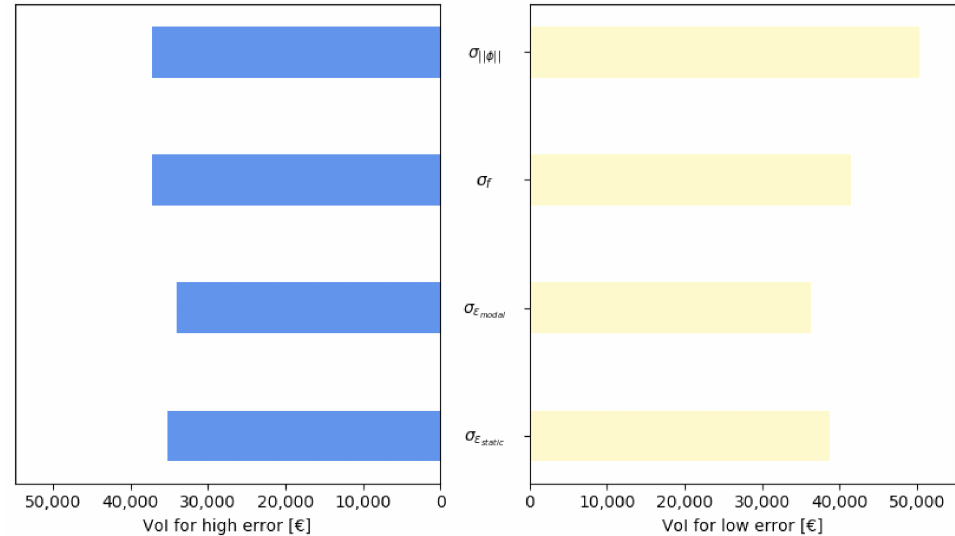
Figure 8. Influence of the measurement error on the VoI.